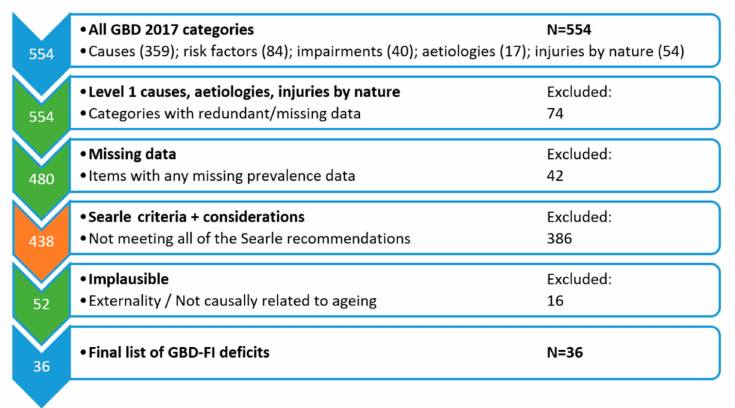
Figure 1. Hierarchical selection of items for the generation of a Global Burden of Disease Frailty Index (GBD-FI), illustrating the number of items excluded according to each criterion applied.